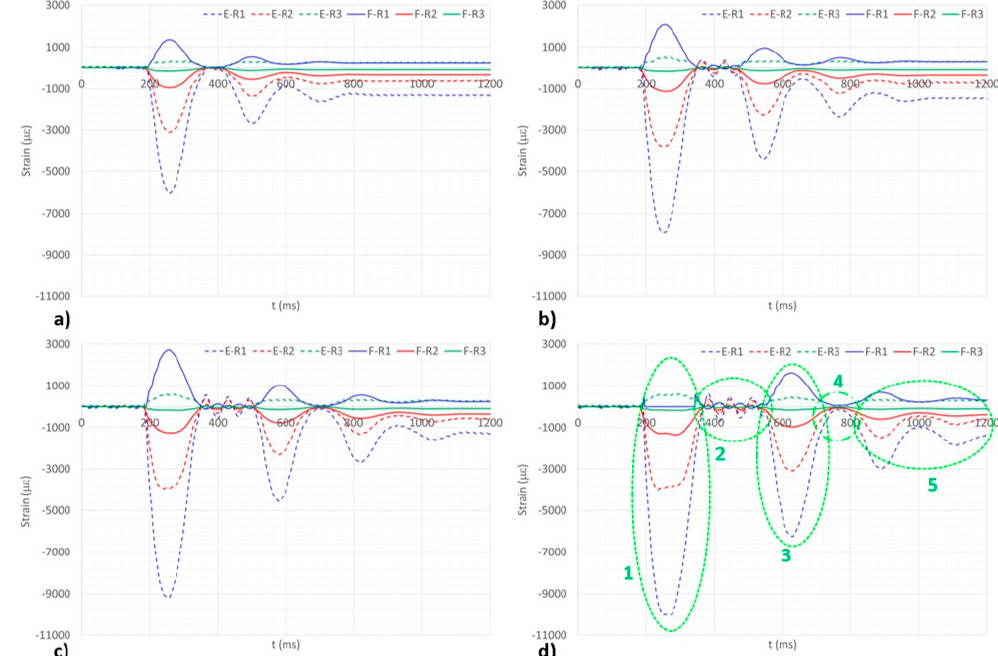
Figure 20. Left leg FBGs rosette signals recorded at four different heights. ( a ) h = 0.05 m; ( b ) h = 0.10 m; ( c ) h = 0.15 m; and ( d ) h = 0.20 m.